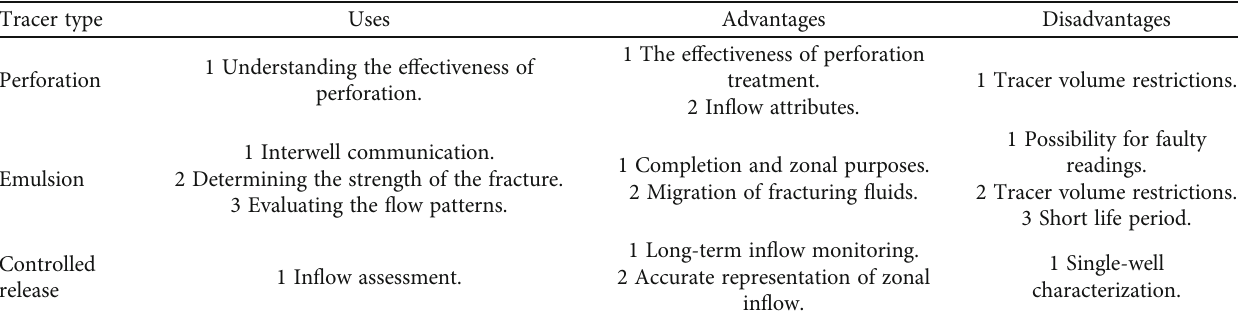
Table 1: Tracers types and their characteristics modi fi ed after